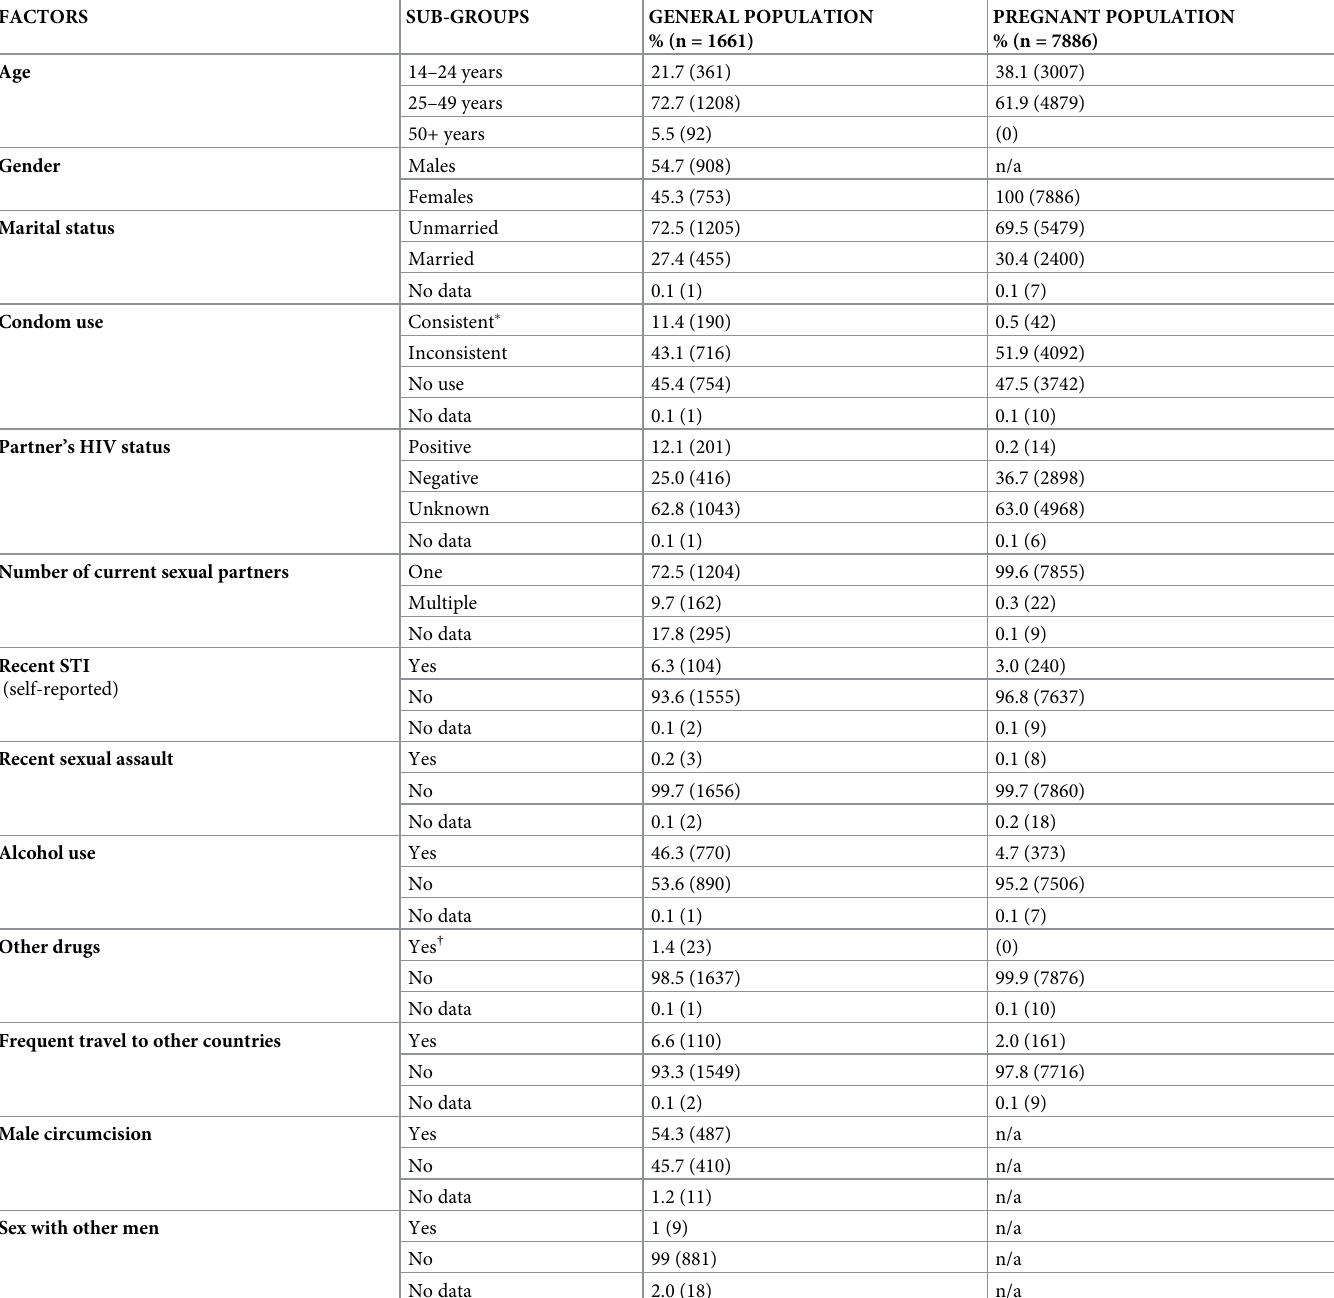
Table 1. Demographic and behavioural risk factors of all study